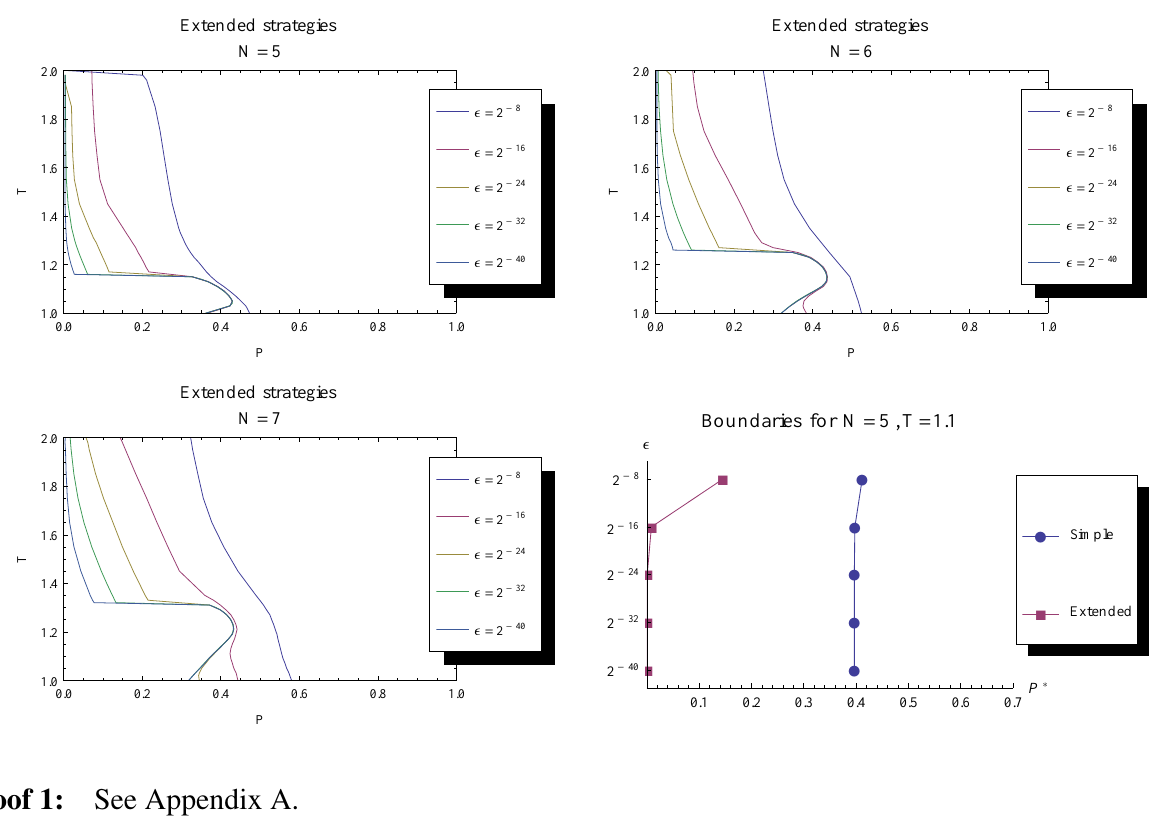
Figure 4. Numerical analysis showing which games have stable fixed points. Stable fixed points have been found to the right of a given line, at which they disappear if P is decreased further. Lowering the mutation rate (cid:15) turns more evolutionary dynamics into having stable fixed points. Runs for N = 5 , 6 , 7 indicate a convergence, as the mutation rate is decreased, towards a fraction of games being without stable fixed points, as seen in the lower left of the parameter space for the different game lengths. To the bottom right the boundary is shown for a particular T = 1 . 1